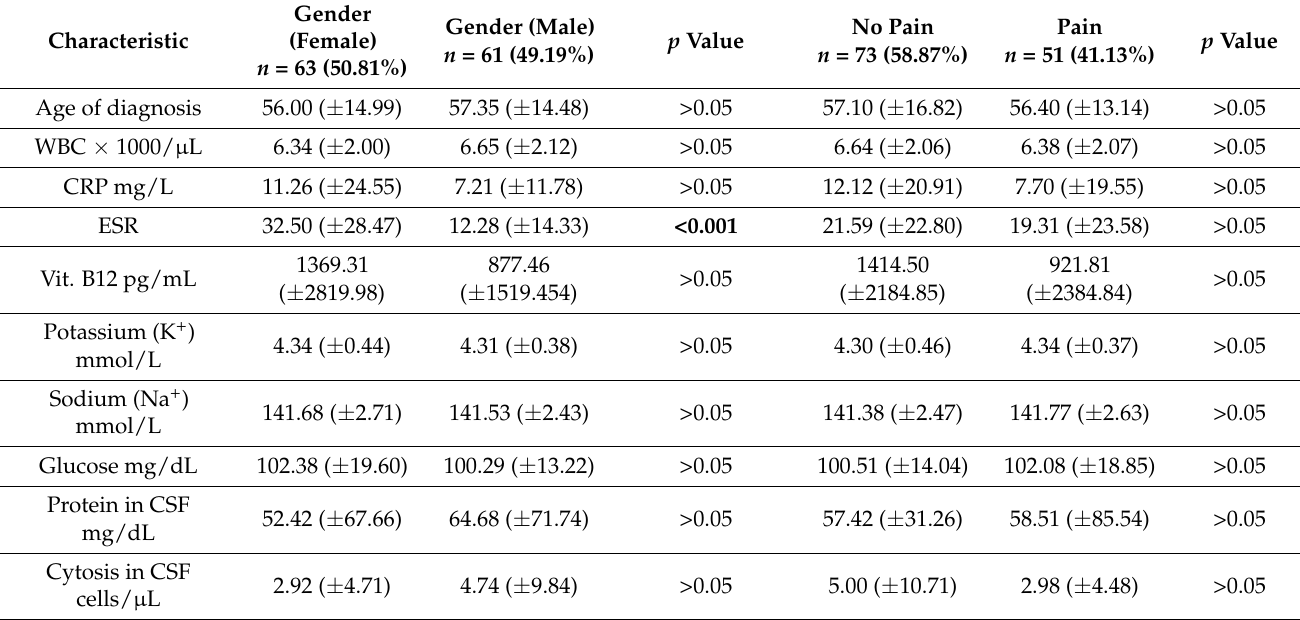
Table 4. Comparison of laboratory test results of patients with and without